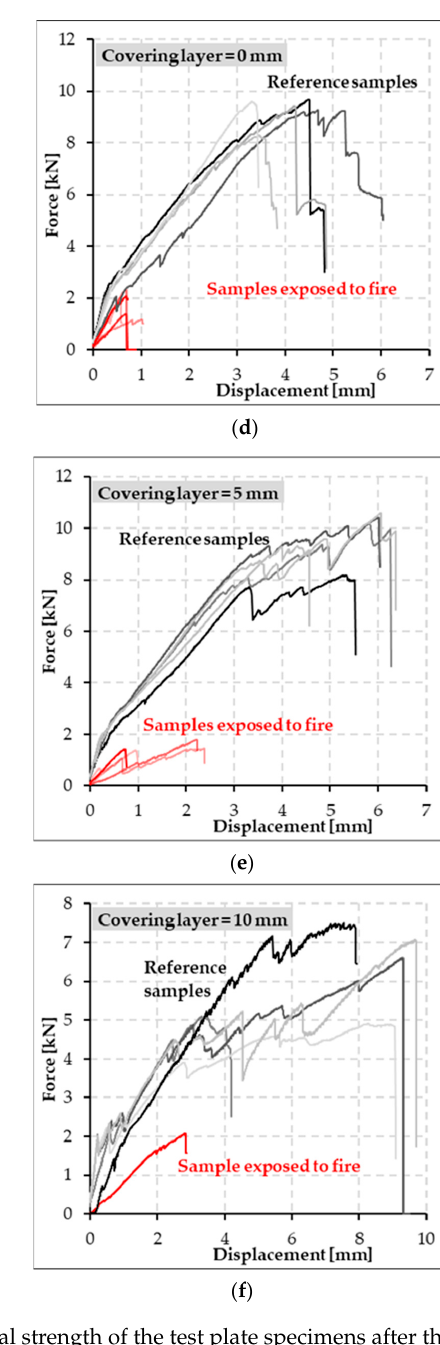
Figure 10. Schematic description of the fire exposure influence to a different type of textile reinforce- ment matrix. Tested specimens with cement suspension matrix at elevated temperatures showed a similar trend of bending strength capacity as the reference specimens (Figure 11a–c).